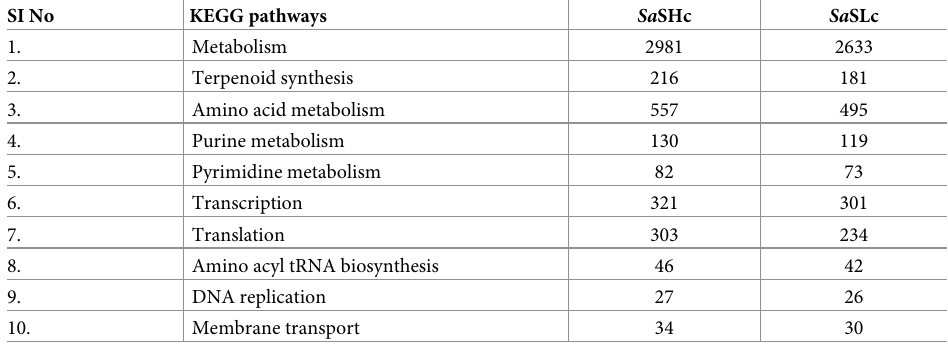
Table 4. Top 10 KEGG pathways mapped in sandalwood ( S . album )